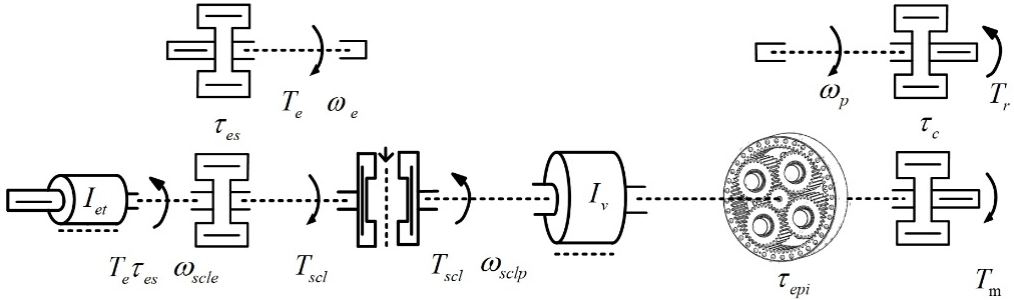
Figure 4. Free body diagram of AMT with the gearshift assistant mechanism during the shifting process.